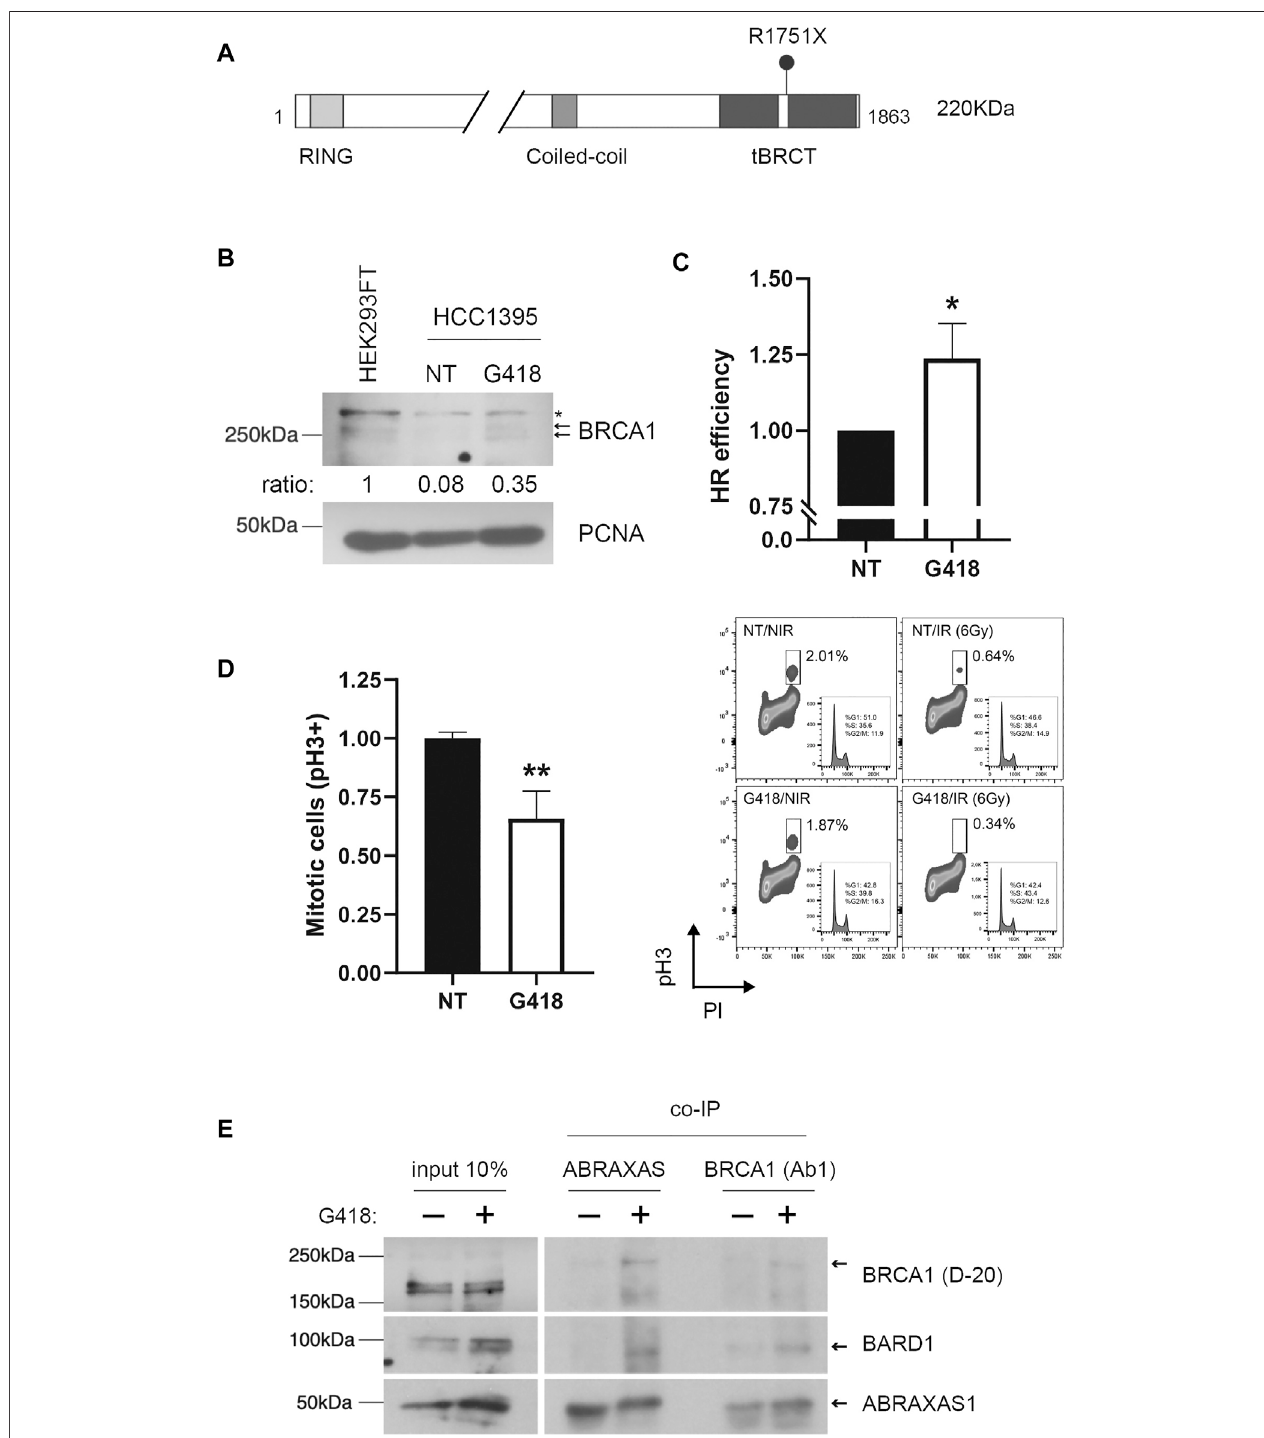
FIGURE 1 | Aminoglycoside treatment restores BRCA1 FL protein expression and function in HCC1395 cells. (A) Schematic representation of BRCA1 protein depicting functional domains and R7151X variant position. Expected BRCA1 FL protein molecular weight: 220 KDa. (B) BRCA1 FL protein pro fi le was assessed in nuclearcellularextractsofHEK293FTnon-treated (NT)andHCC1935cellseitherNTortreatedwithG418(300 μ g/ml)for48 h.ArrowsindicateBRCA1phosphorylated formsand (*)indicatesanon-speci fi cband.PCNA wasusedasaloadingcontrol.Relativedensitometric quanti fi cationsofBRCA1bandsareindicated(normalized to PCNA loading control). (C) Homologous recombination (HR) repair ef fi ciency quanti fi cation was evaluated in HCC1935 cells NT or treated with G418. HR repair ef fi ciency was analyzed by fl ow cytometry (mean of 3 independent experiments, error bars represent SD; * p < 0.05). (D) FACS analysis of PhosphoH3 ser10 as afunction